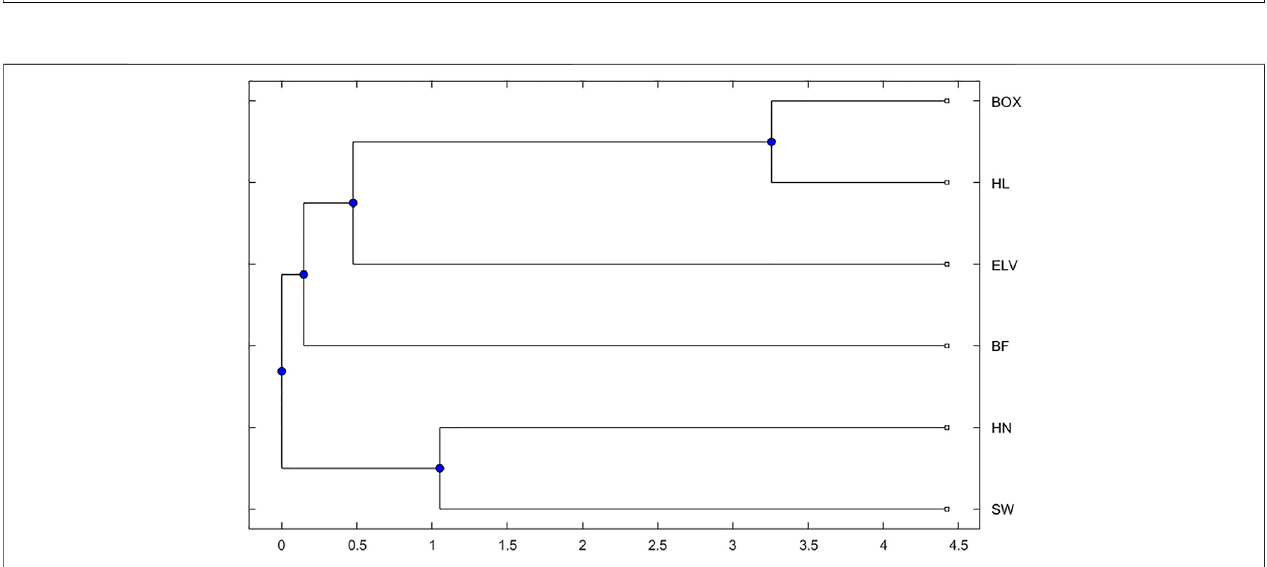
FIGURE 8 | Cluster and distancesof sites from the Geometric Morphometrics analysis. Abbreviations: BF, Brandon Fields; BOX, Boxgrove; HL, High Lodge; ELV, Elveden; HN; Hitchin, SW, Swanscombe.